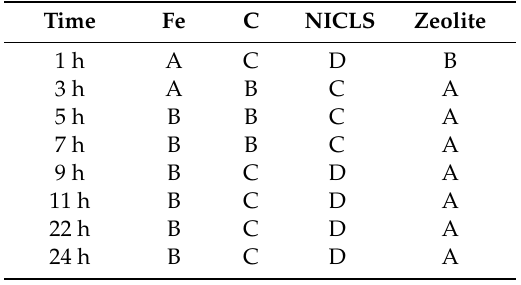
Table 5. Variance significance analysis of Fe, C, NICLS, and zeolite phosphorus removal.